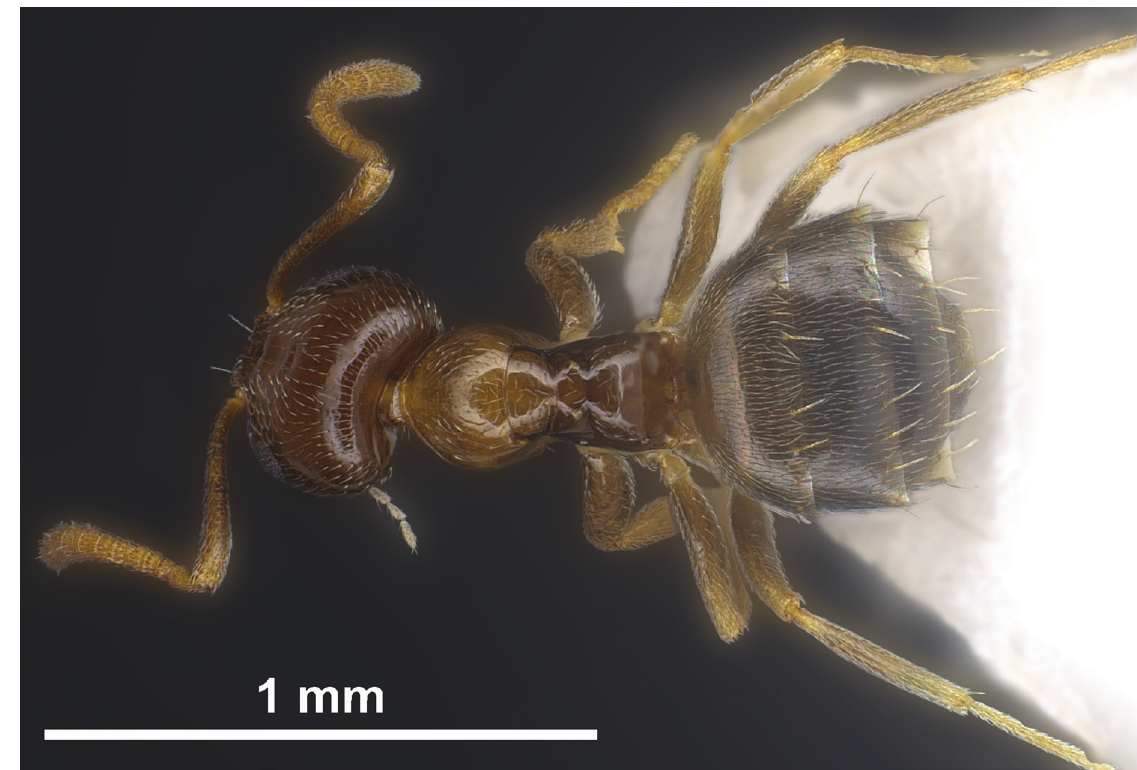
Figure 8. Dorsal aspect of the holotype worker of Plagiolepis invadens sp.